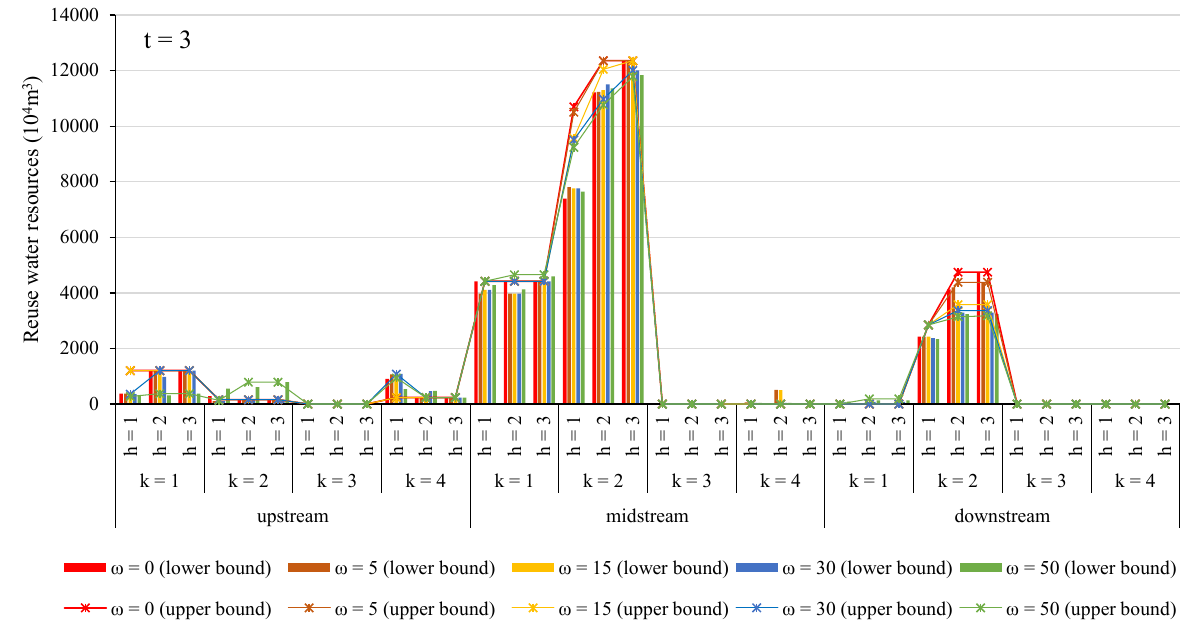
Figure 13. Reused water resources for by region in the Fenhe River Basin in period 3.